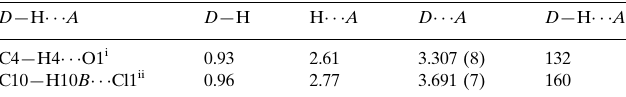
Hydrogen-bond geometry (A˚ , (cid:2)